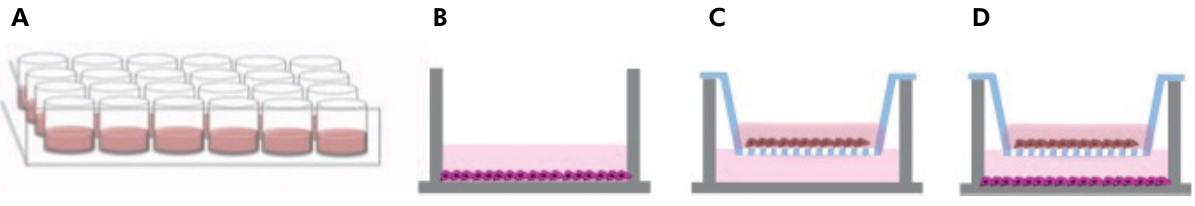
Figure 1. Schematic representation of the monolayer and co-culture models employed: (A) 24-well cell culture plate; (B) monolayer model for gingival fibroblasts; (C) monolayer model for epithelial cells; (D) co-culture model with epithelial cells plated on the insert and gingival cells in the lower